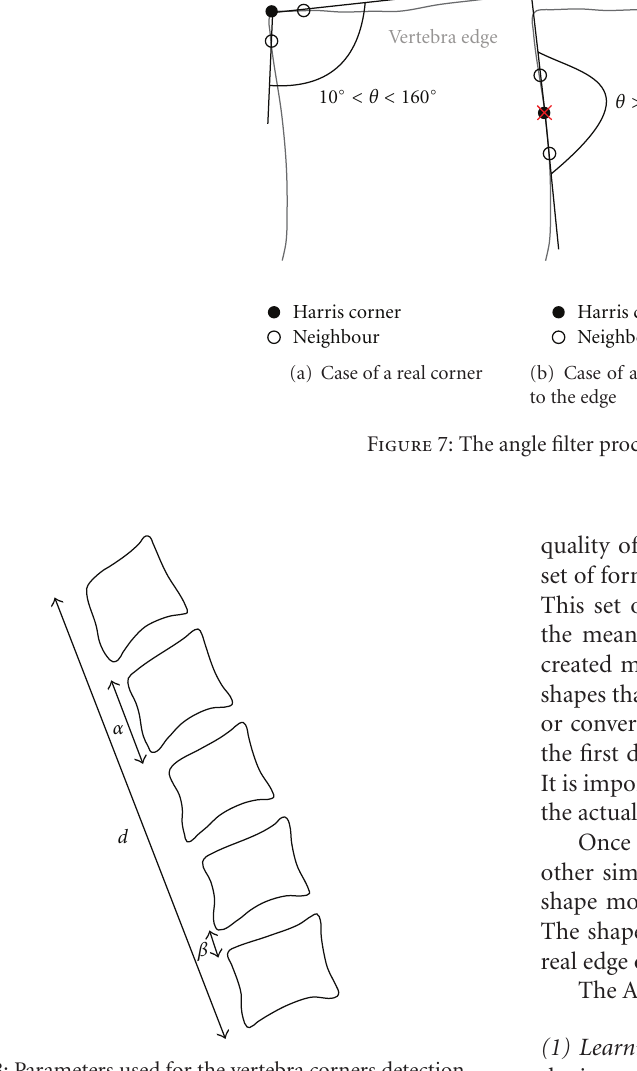
Figure 8: Parameters used for the vertebra corners